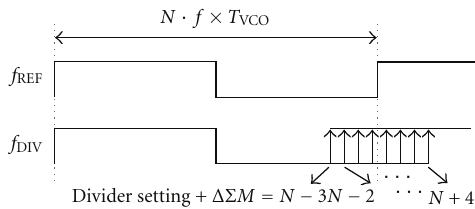
Figure 5: f DIV clock period jittering at the lock state with a ΔΣ modulator activated in a ΔΣ fractional- N PLL.